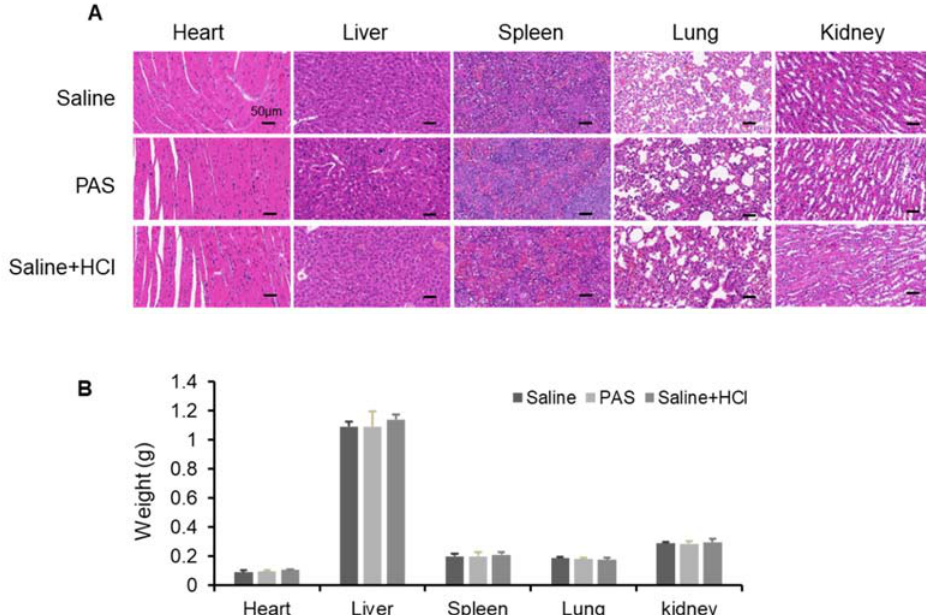
Figure 5. Biological safety test after long-term PAS injection. Nude mice bearing A375 xenografts were treated for 18 days with saline, PAS, or HCl used to adjust saline pH to 2.5. ( A ) The histomorphological features of murine organ slices after PAS treatment. ( B ) Effect of PAS on organ weight. Data represent the mean ± SD; n = 4; scale bar = 50 µ m. Tables 1–3. Blood biochemical indices after long-term PAS injection. Nude Table 1. Analysis of liver function.